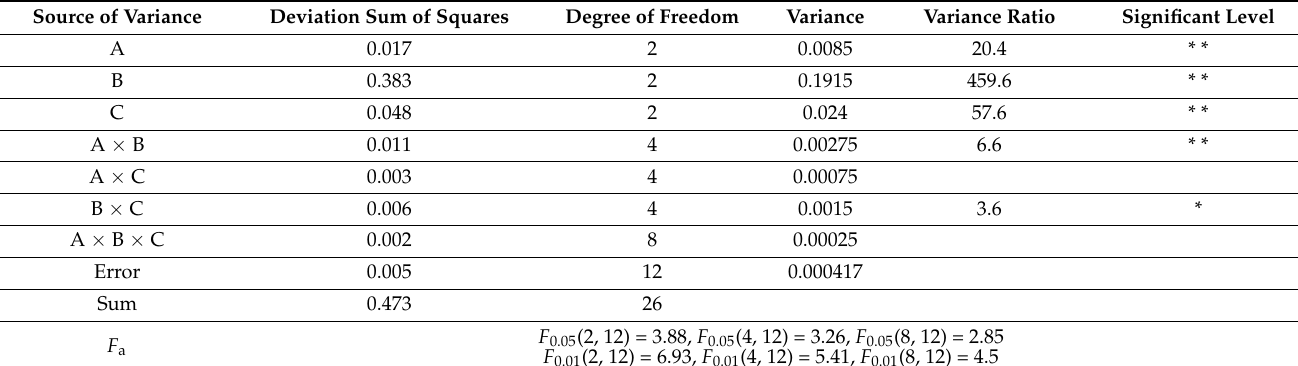
Table 7. Variance analysis of effective Y-axis extension distance.